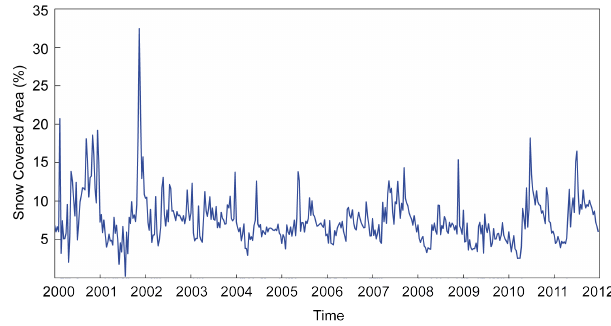
Figure 11. Snow-covered area observed from gap-filled MODIS snow products at a 10-day time step over the Andean